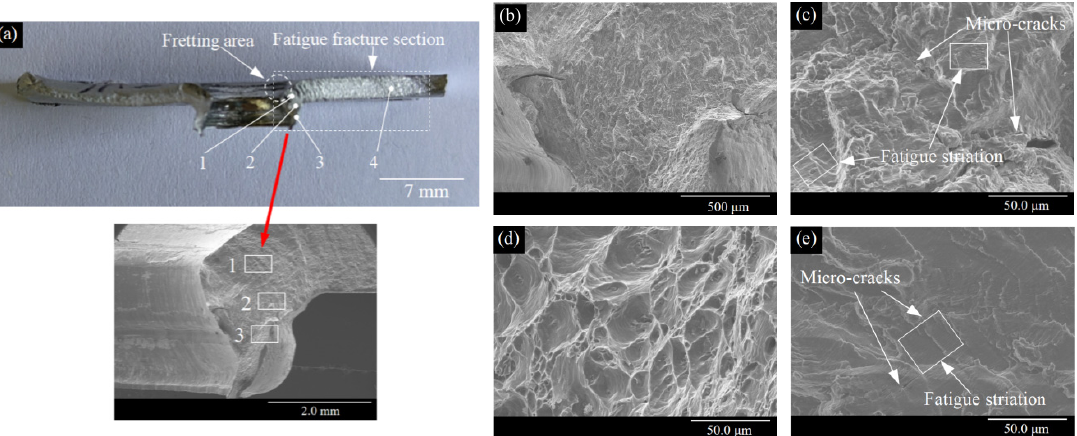
Figure 14. Fatigue fracture micro-morphology of AA5052 sheet in the SA joint. ( a ) Macroscopic morphology of the fatigue fracture; ( b ) magnified morphology of area 1; ( c ) micro-morphology of area 2; ( d ) micro-morphology of area 3; ( e ) micro-morphology of area 4.